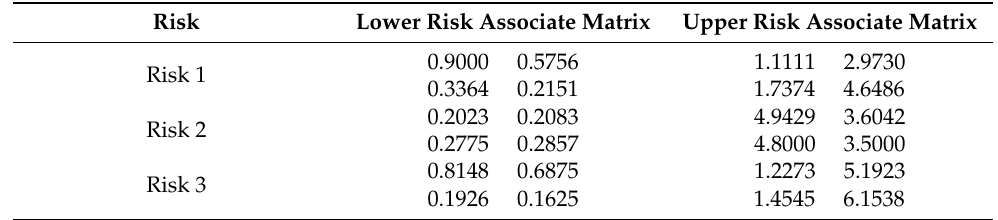
Table 13. Risk associate matrix.